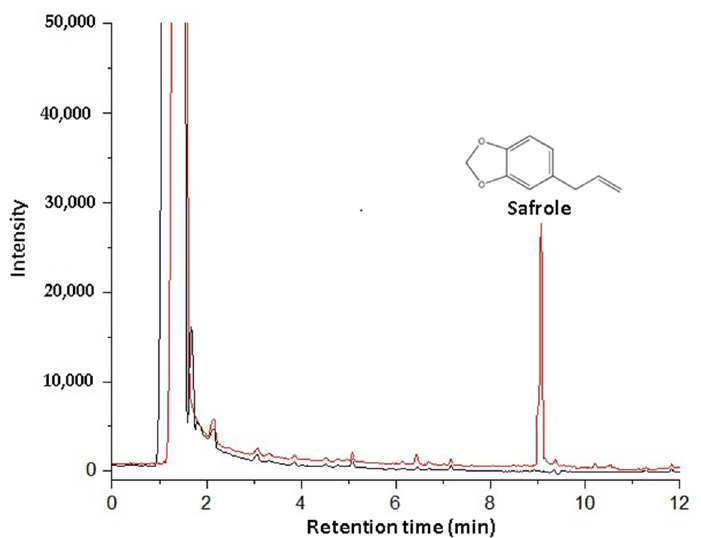
Figure 4. In red, chromatogram obtained from the analysis of beans fortified with safrole (t R = 9.0 min) and black, chromatogram of white matrix + methanol after extraction and analysis by HS-SPME-GC/FID, ( n = 3).